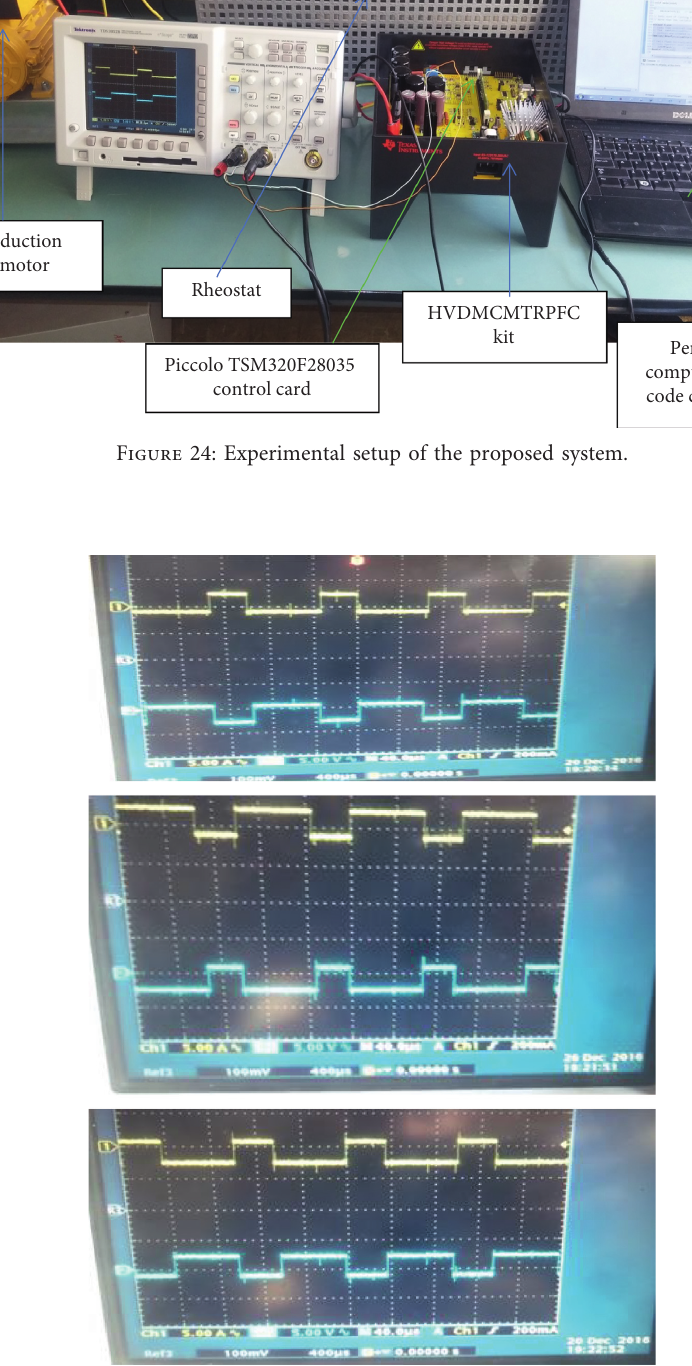
Figure 25: The six PWM output signals from DSP while the motor is running at